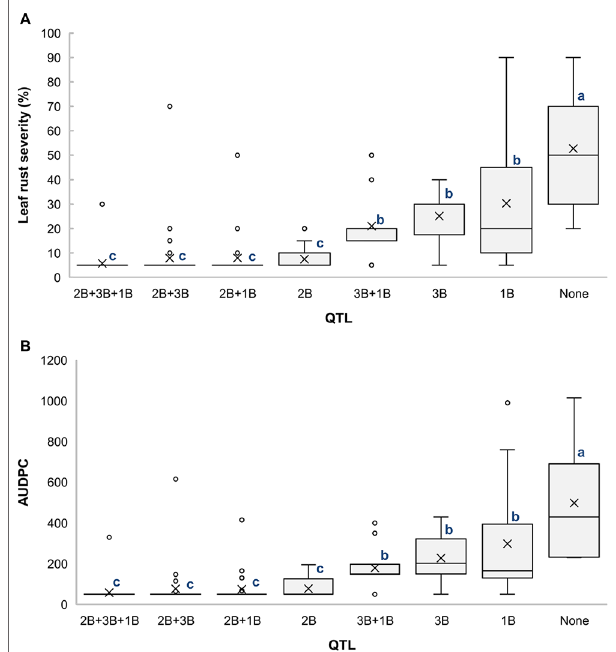
FIGURE 4 | Boxplots illustrating the effects of QLr.usw-2BS, QLr.usw-3B , and QLr.usw-1BL.2 on (A) LRS and (B) AUDPC in the Saragolla/ATRED #2 population. The QTL effects are shown in isolation and in combination. Means with the same letter are not significantly different from one another at P <